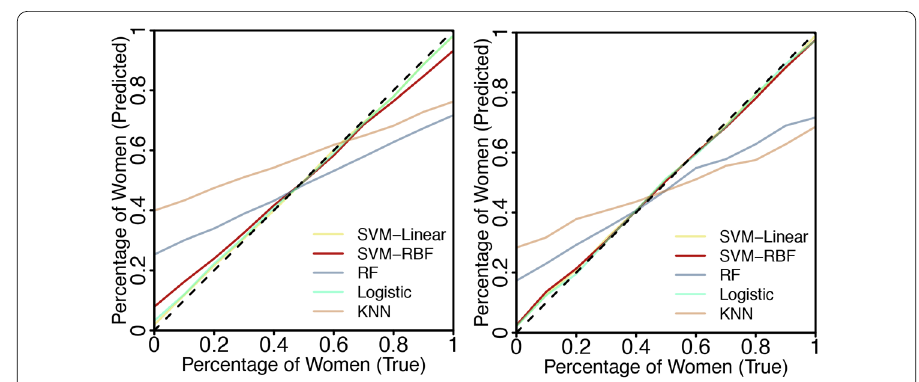
Figure 6 True versus predicted gender balance in EU (left) and SA (right).